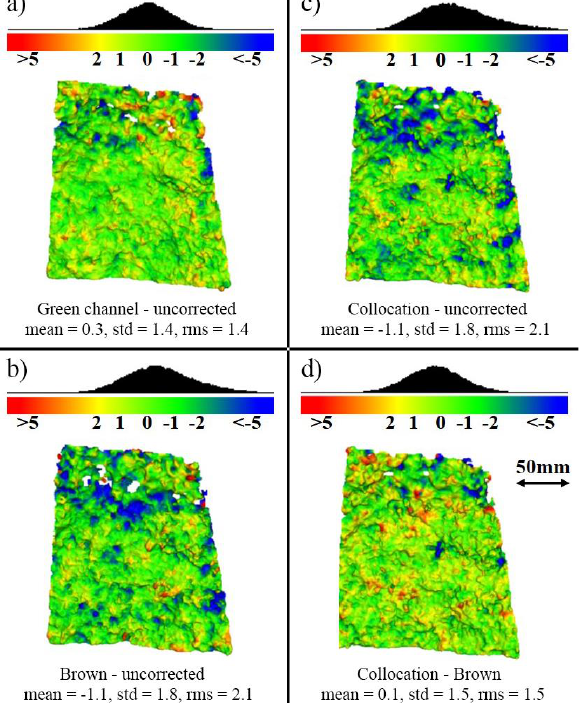
Figure 9. Comparison of dense point clouds for an ocean floor area. As in Fig.7, a) to c) compare models generated by the green channel, the Brown dataset, and the collocated dataset with the uncorrected GoPro dataset. In d), the difference between the collocation and Brown datasets are shown. All numbers in millimeters.